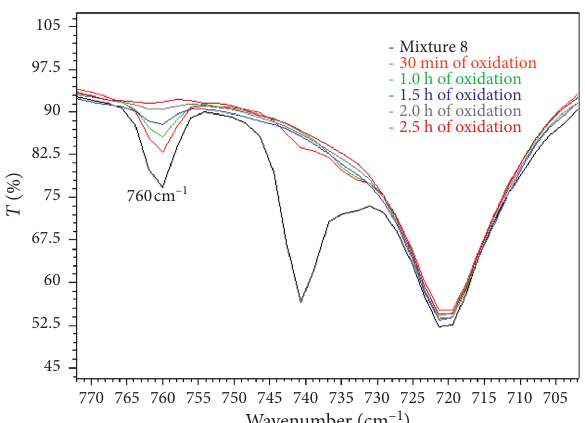
Figure 7: FT-IR liquid spectra of mixture 8. Peaks of benzothiophene and dibenzothiophene in the out-of-plane bending C-H region are